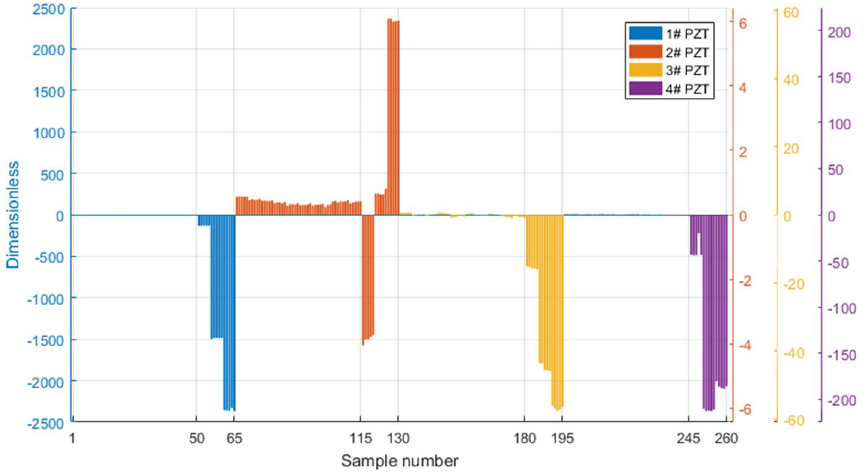
Figure 14. Histogram of the comprehensive principal component